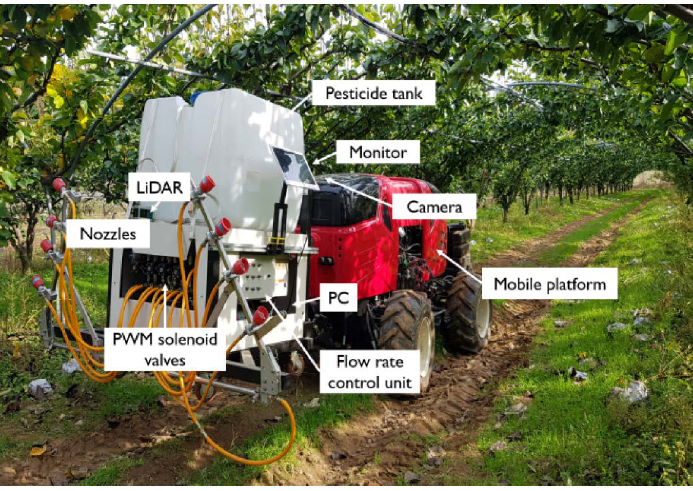
Figure 14. Intelligent spraying system